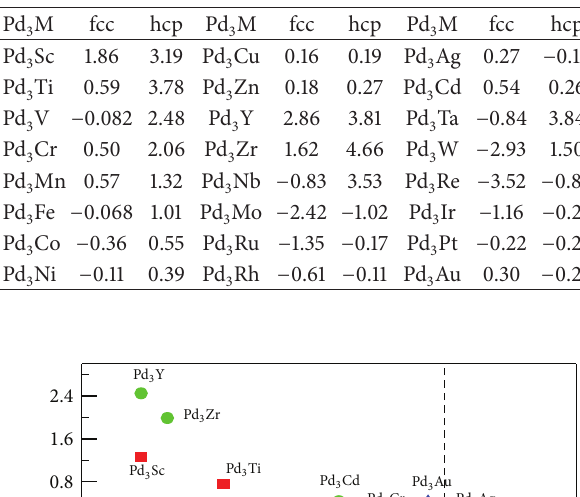
Table 4: The DFT calculated surface segregation energies of Pd, Δ𝐸 (eV) for various Pd M (M is 3d, 4d, and 5d transition metals) segr 3 alloys in systems containing atomic adsorbed in the fcc and hcp positions.